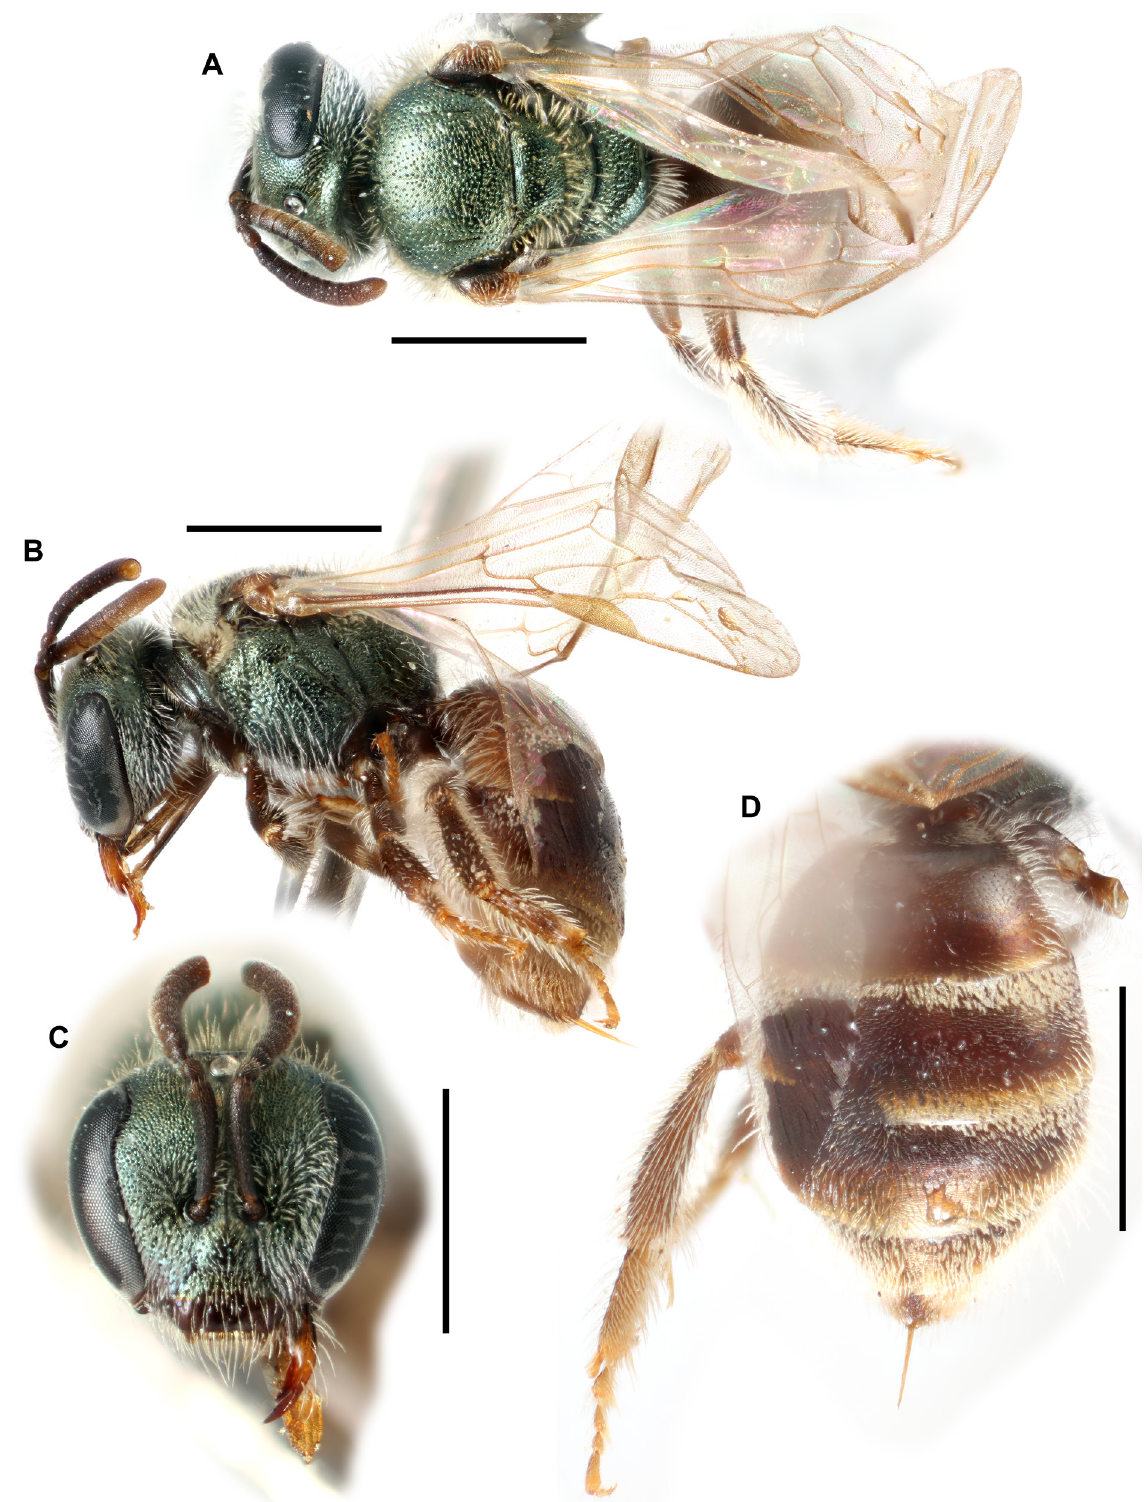
Fig. 15. Lasioglossum ( D .) diabolicum sp. nov., ♀, holotype (BBSL409921). A . Dorsal habitus. B . Lateral habitus. C . Face. D . Metasoma. Scale bars = 1